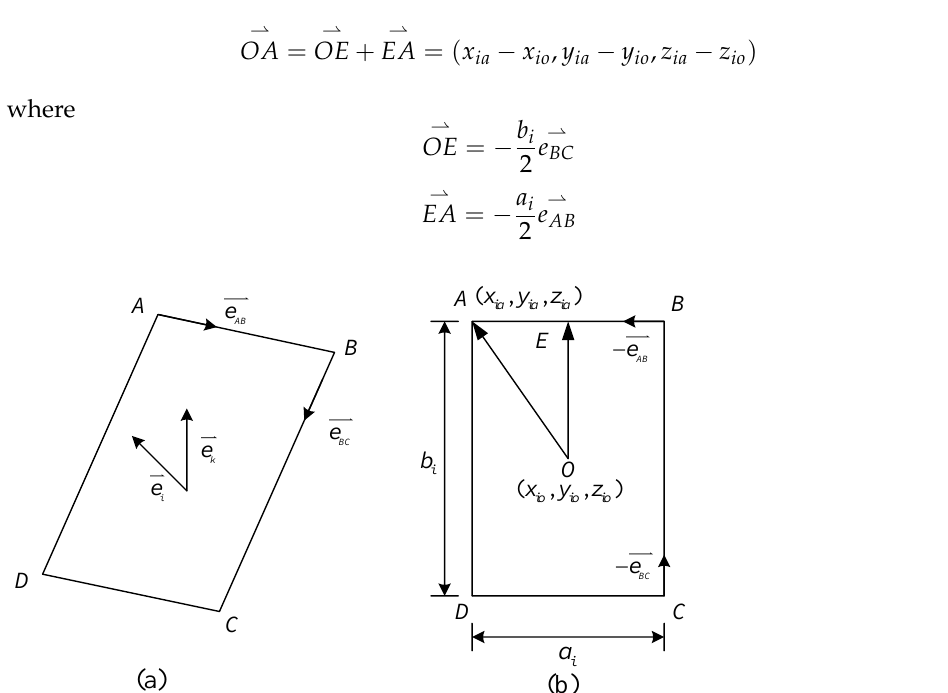
Figure 1. The process of obtaining the coordinates of the vertices of the i th rectangular fracture ( a , b ). It follows from the relationship between the normal vector and the angle and direction (cid:42) e i = ( sin α i sin β i , sin α i cos β i , cos α i ) of the dip that